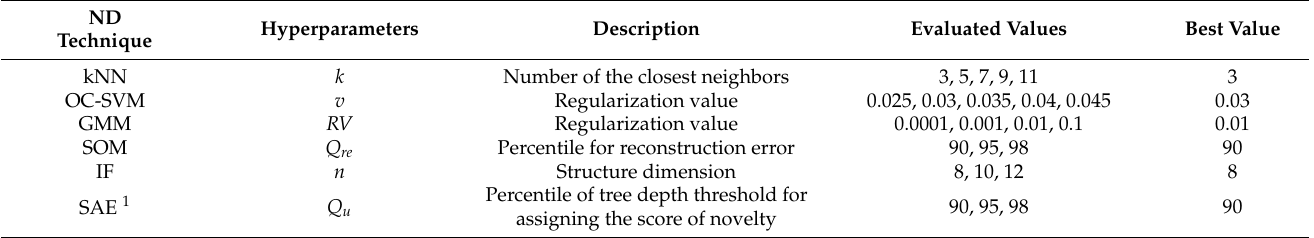
Table 4. Techniques for ND and best hyperparameters used.